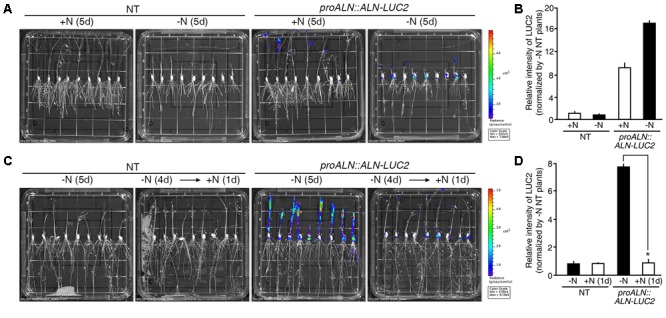
Luminescence resulting from proALN::ALN-LUC2 plants is strong under low N conditions. (A) Images of 5-day-old NT (non-transgenic) and proALN::ALN-LUC2 plants grown on GM+N (growth media +N) or GM–N media. (B) Relative intensity of the luminescence in T3 homozygous proALN::ALN-LUC2 plants under the same conditions as in (A). (C) Images of 5-day-old NT and proALN::ALN-LUC2 plants grown on GM–N for 5 days, or grown on GM–N for 4 days followed by addition of 100 mM ammonium nitrate for 1 day. (D) Relative intensity of the luminescence in T3 homozygous proALN::ALN-LUC2 plants under the same conditions as in (C). Data shown are the mean + SD of 5 T3 homozygous proALN::ALN-LUC2 lines (n = 10 for each line). NT plants grown on GM–N were used as a control for normalization. Asterisks indicate significant differences based on a 95% confidence interval by a Student’s t-test.